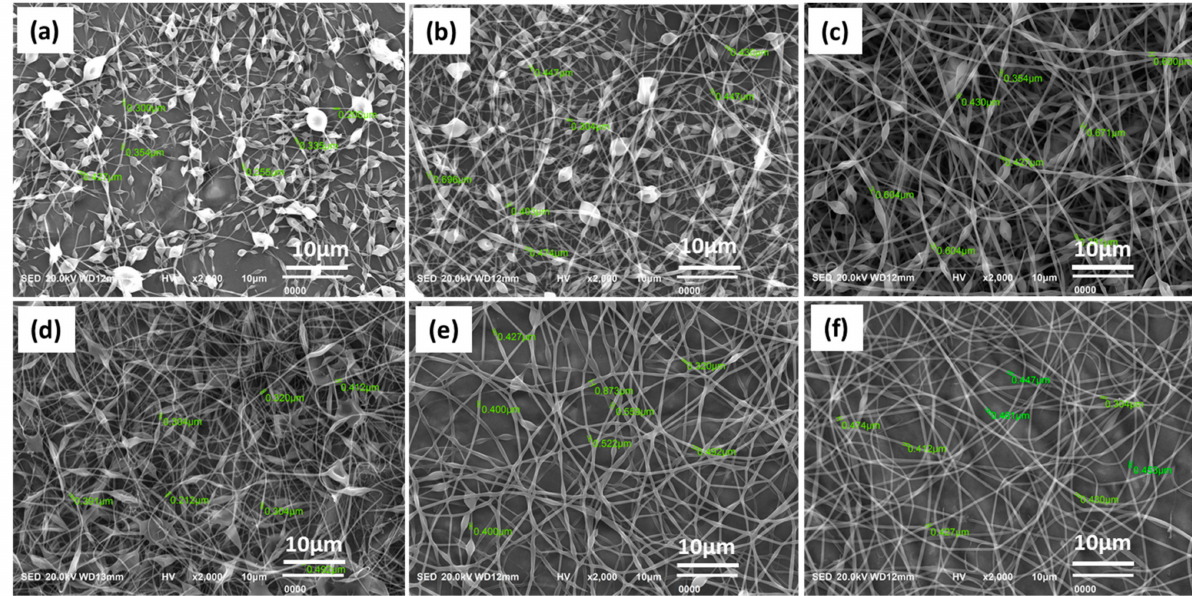
Figure 7. The SEM images of p (ASF-AGE-NIPAAm) hydrogel nanofibers with different polymeriza- tion times: ( a ) 30 min, ( b ) 60 min, ( c ) 180 min, ( d ) 240 min, ( e ) 300 min and ( f ) 360